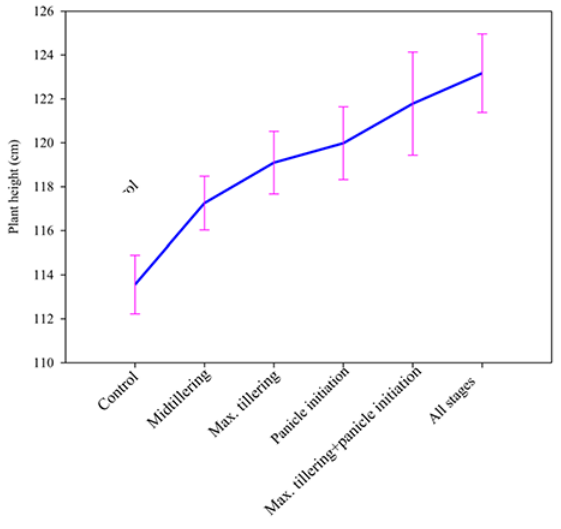
Figure 1 Effect of the foliar application of nutrients on the plant height in 2 years. Vertical bars indicate the LSD value by the t test at 5%.